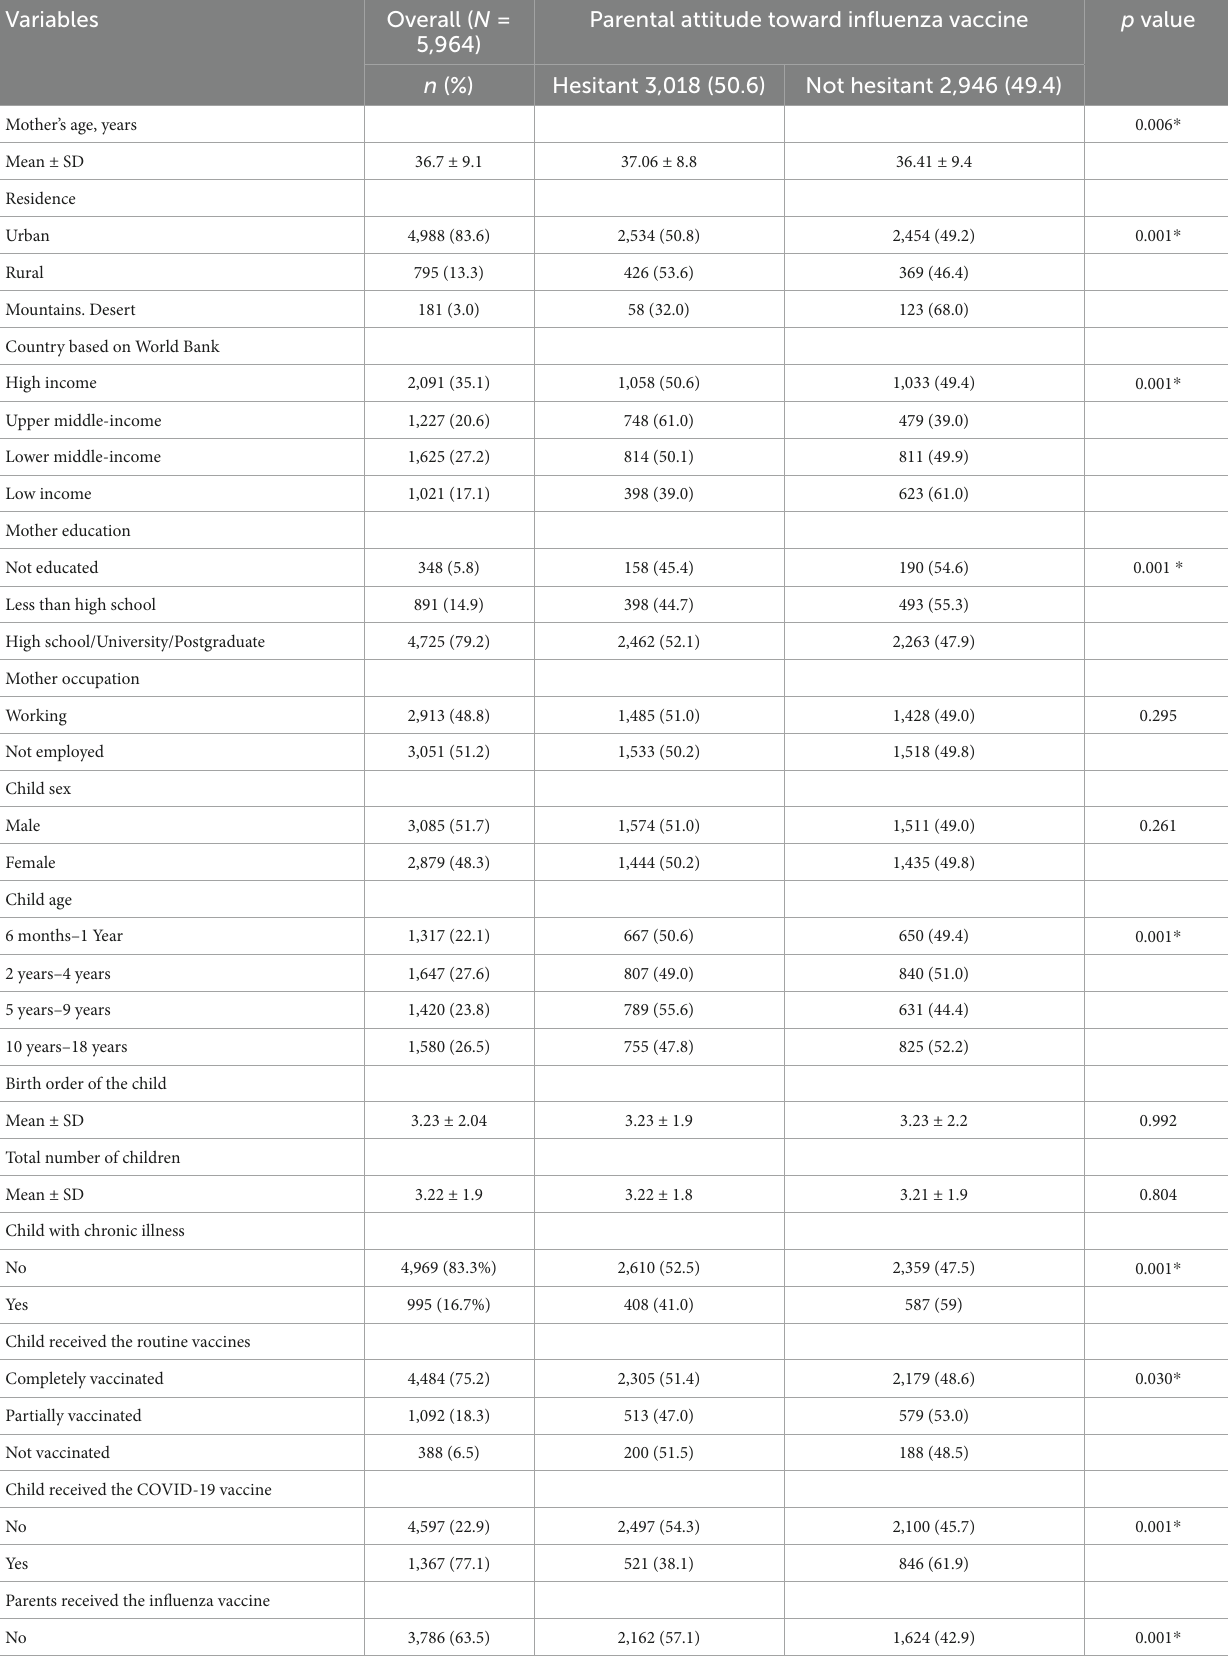
TABLE 1 Characteristics of study participants by parental attitudes toward influenza vaccine. Variables Overall ( N =